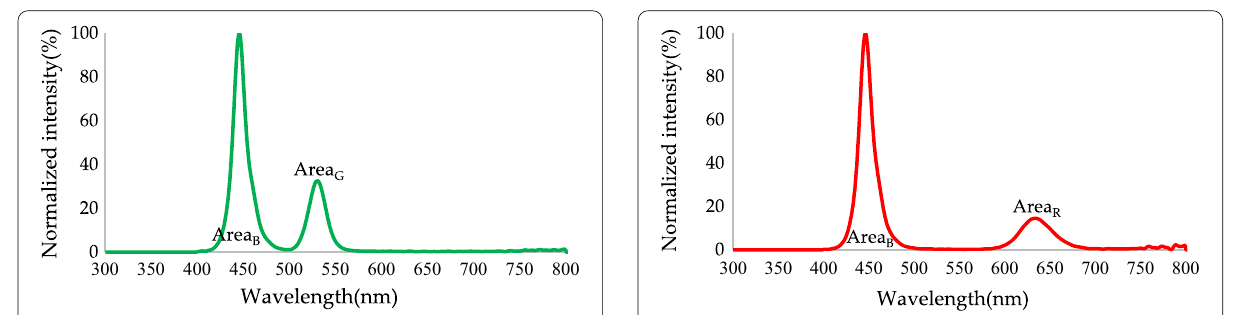
Fig. 12 Normalized blue light without RCPEF conversion to red spectrum by QDs